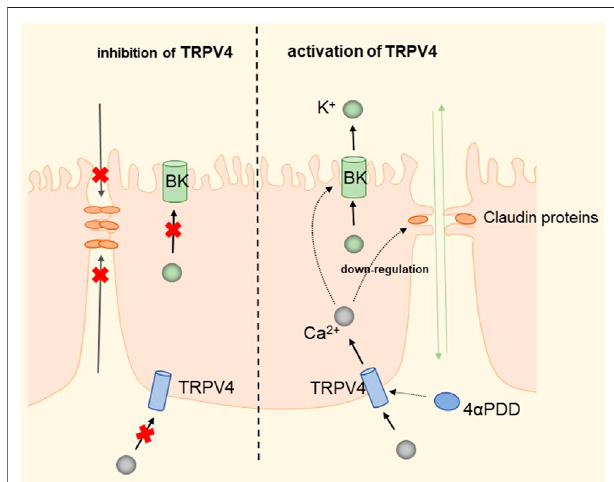
FIGURE 7 | Regulation of transcellular and paracellular pathways by TRPV4 in HC11 cells. TRPV4 induces Ca 2+ in fl ux by activation by 4-PDD, which activates BK channels to provide transcellular ion channels. The process down-regulates sealed claudin proteins and alters the structure of tight junctions, increasing paracellular permeability and facilitating milk